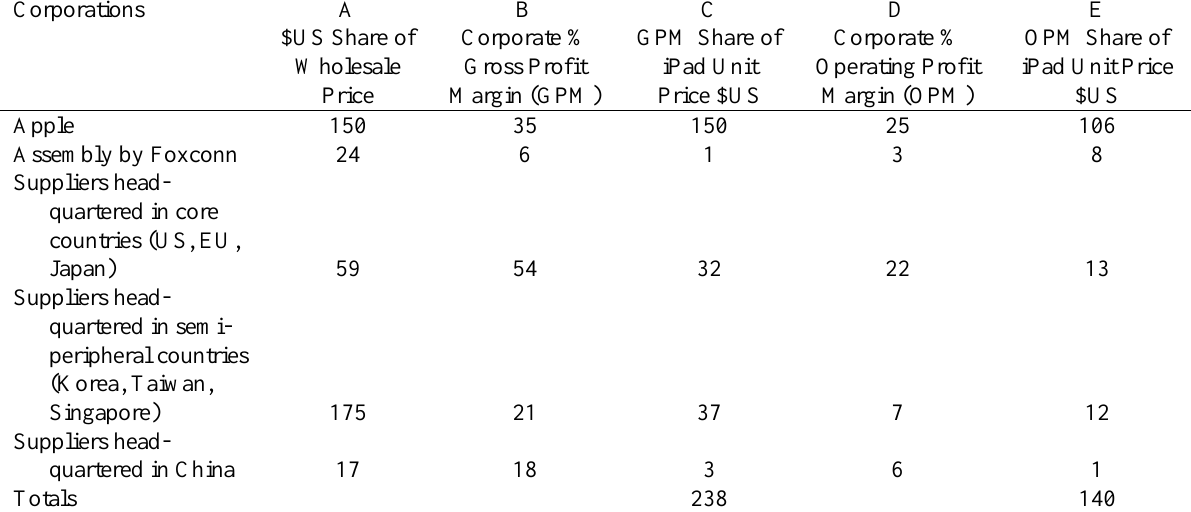
Table 2. Corporate Degree of Monopoly as Represented by Gross Profit Margins and